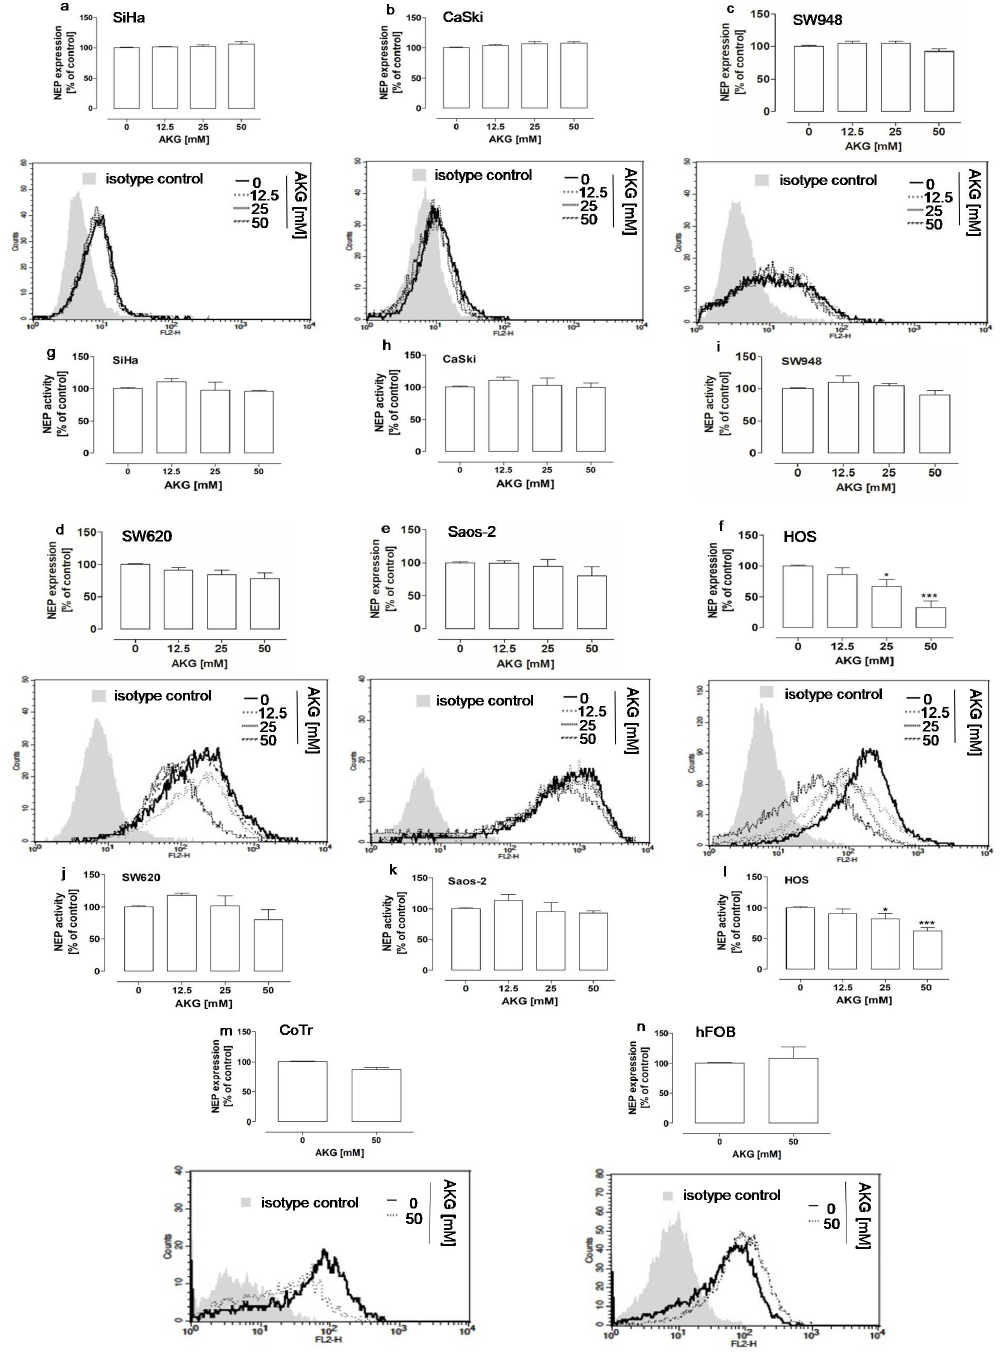
Figure 2. AKG downregulated the protein level and activity of NEP in highly aggressive osteosar- coma cells. The expression at the protein level ( a – f , m , n ) and the activity level ( g – l ) of NEP in